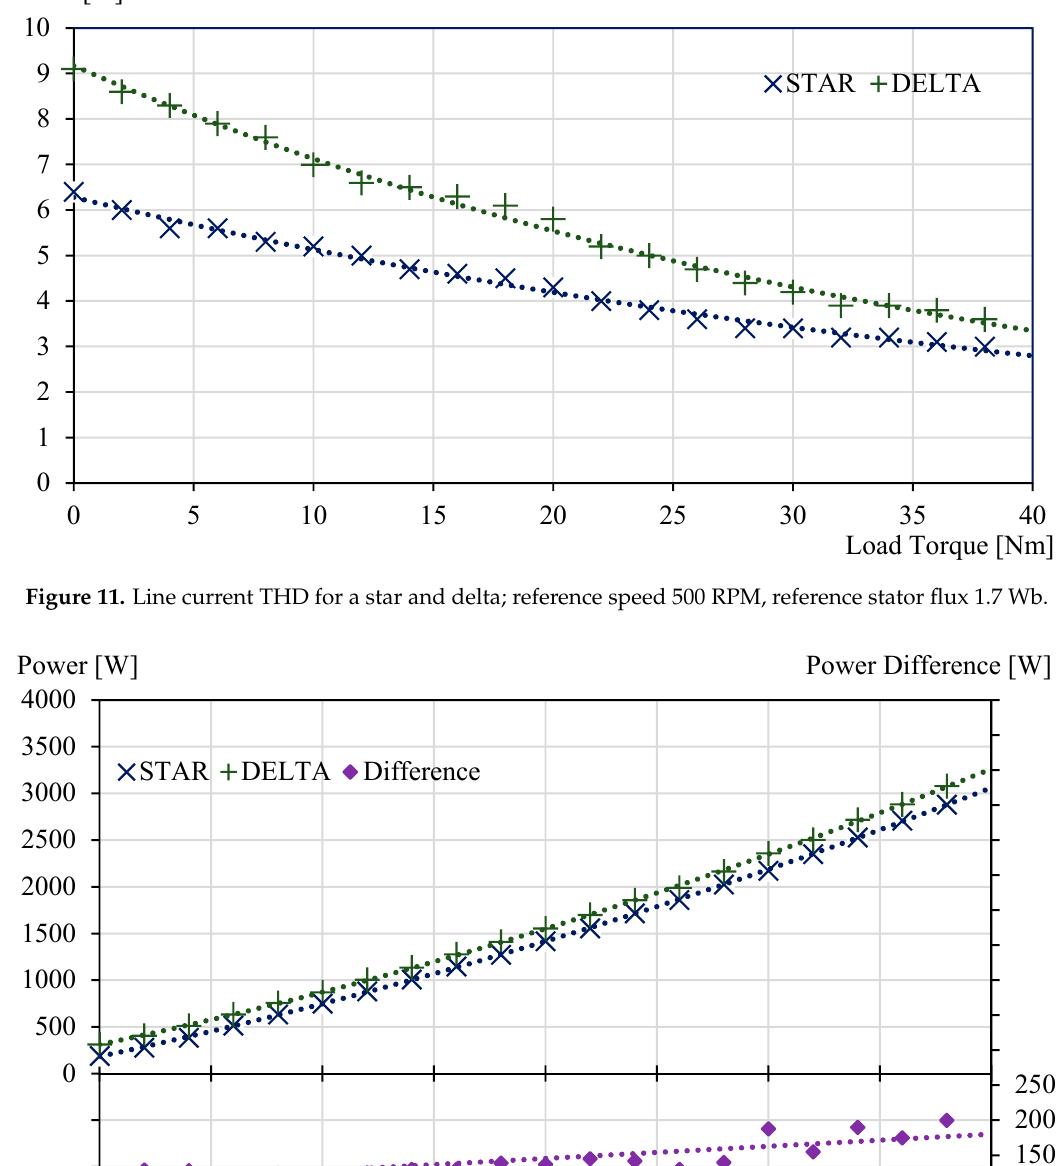
Figure 13. Line current comparison for a star and delta winding connection; reference speed 1000 RPM, reference stator flux 1 Wb, load torque 15 Nm.